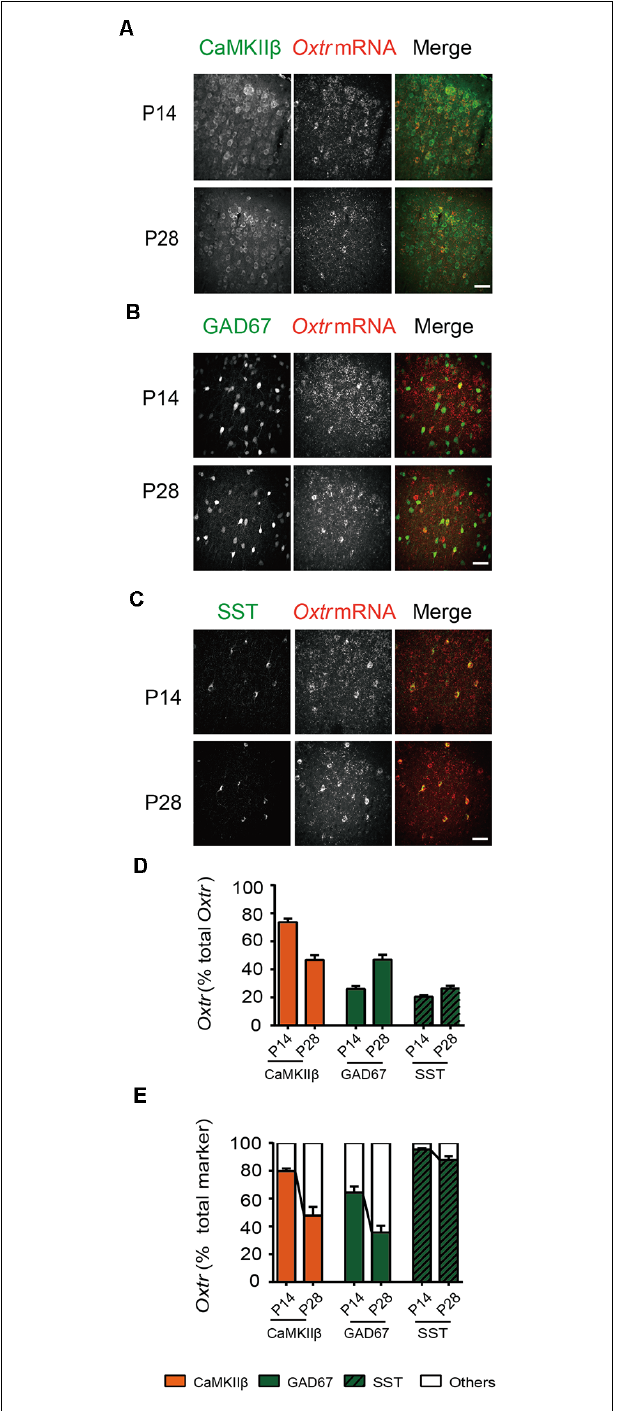
FIGURE 3 | Oxtr mRNA expression in glutamatergic and GABAergic neurons. (A) Representative images of Oxtr mRNA co-labeling with the glutamatergic neuron marker CaMKII β , age of mice as indicated in this and subsequent panels. (B) Representative images of Oxtr mRNA co-labeling with the GABAergic neuron marker GAD67. (C) Representative images of Oxtr mRNA co-labeling with SST, a marker for a subtype of GABAergic neurons. (D) Oxtr mRNA expression in different cell types in P14 and